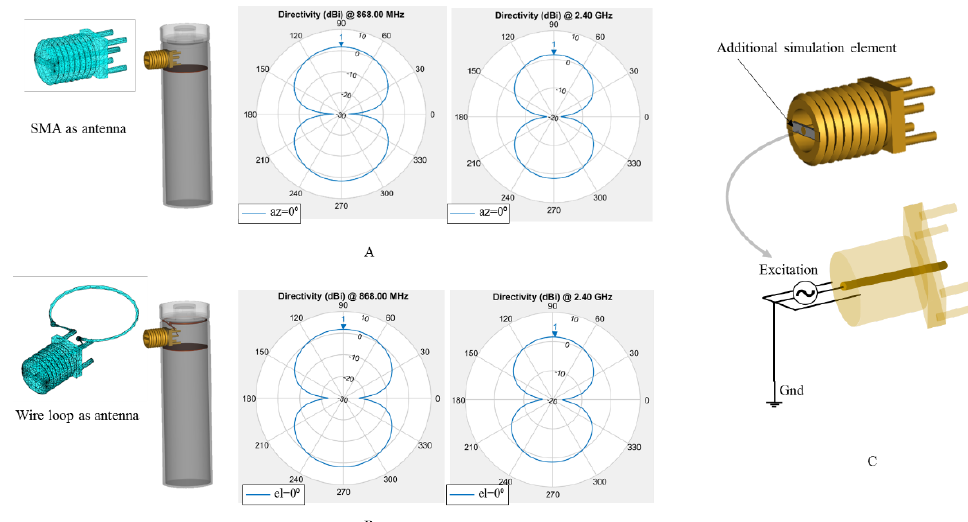
Figure 5. MATLAB RF test setup initial azimuth and elevation planes polar plots for 868 MHz and 2.4 GHz communication with the SMA as radiative element ( A ), the wire loop connected to the SMA ( B ) and the modification on the 3D design for the SMA to insert the simulation RF excitation source ( C ). Since the radiation pattern for dipole and loop antenna are resembling in shape with a torus while 90° offset from each other, the azimuth (az) plane for SMA is similar with the elevation (el) plane for the loop.